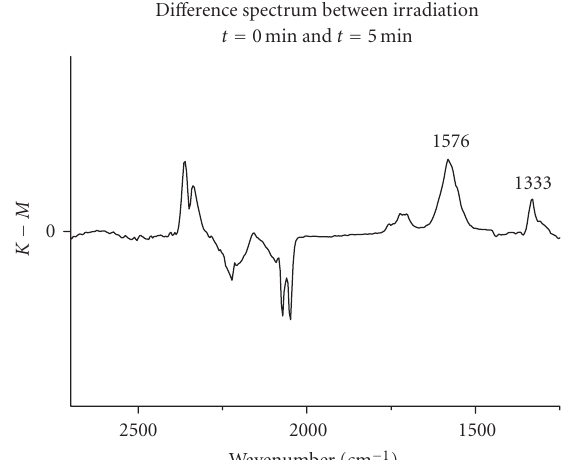
Figure 9: Initial products of d4-methanol oxidation.